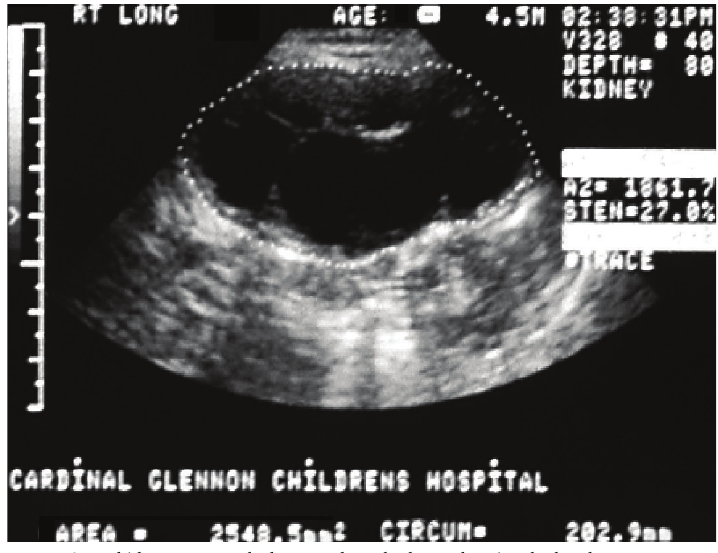
Figure 3: Same kidney 1.5 months later. SFU grade IV hydronephrosis; Calculated HI 27. The dotted line outlines the entire renal area, including renal pelvis [black] and parenchyma (dark gray). While the SFU grade remained the same, the HI has deteriorated significantly, indicating an actual worsening